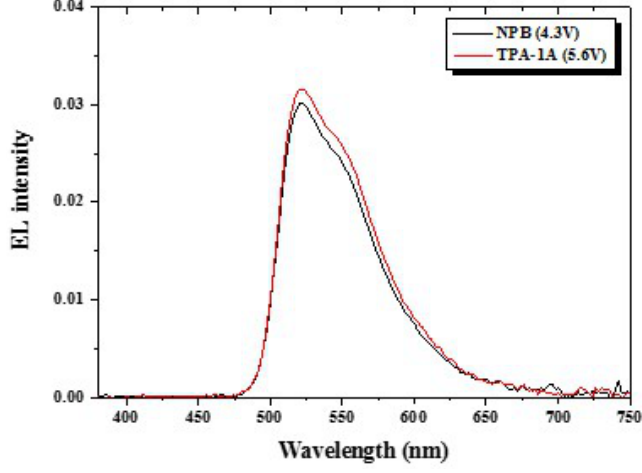
Figure 6. Electroluminescent (EL) spectra of fabricated green PhOLEDs.